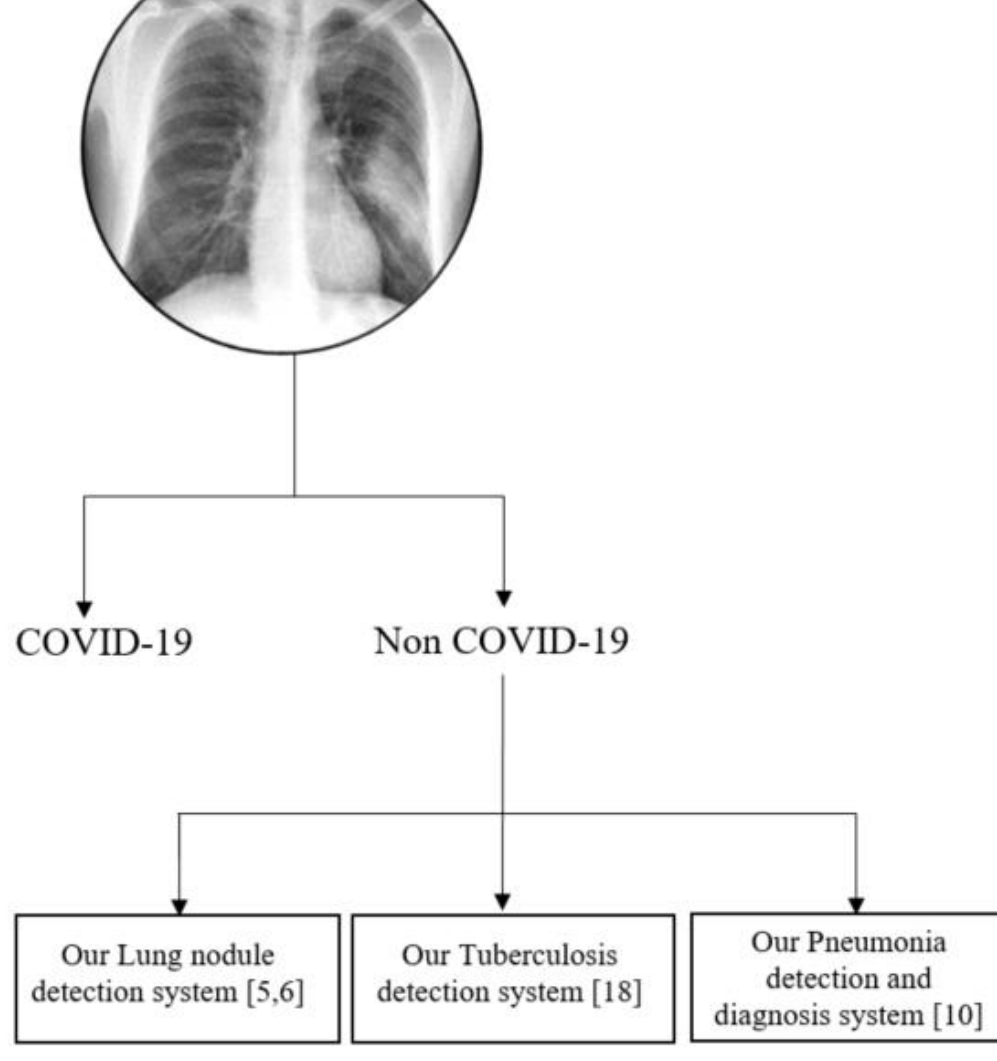
Figure 11. Proposed integrated CAD system for chest radiographs.